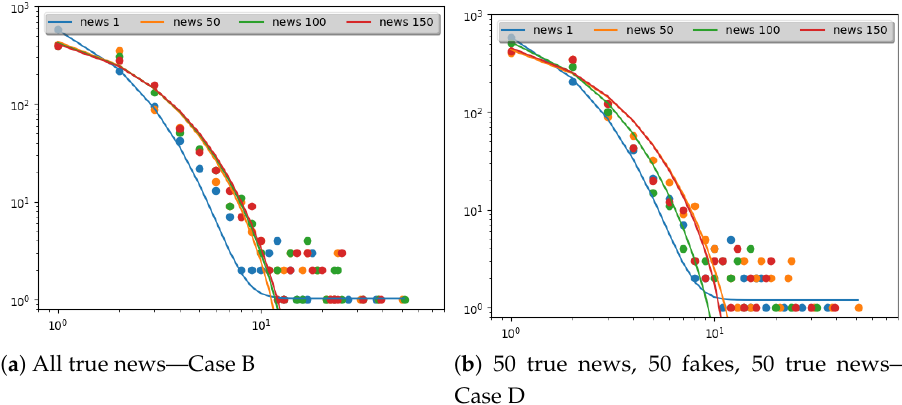
( b ) 50 true news, 50 fakes, 50 true news— Figure 3: Credibility distribution over the network - 50 true news, 50 false news, 50 true news - Case D Case D